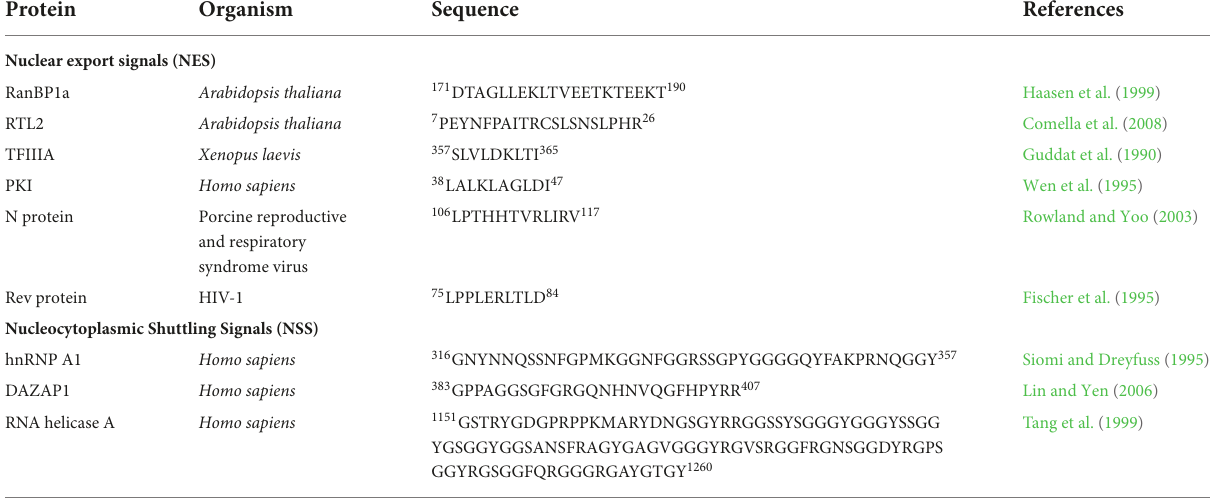
TABLE 3 Nuclear export signals and nucleocytoplasmic shuttling signals. Protein